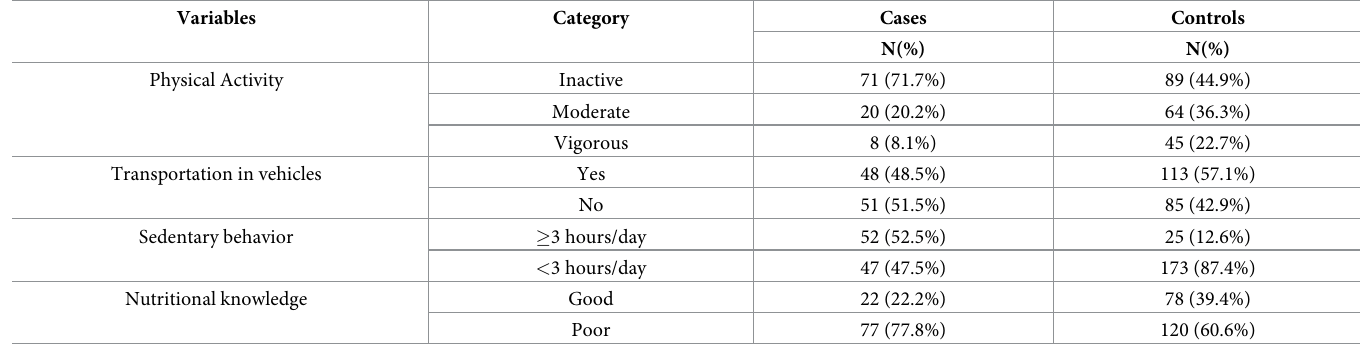
Table 3. Distribution of physical, sedentary behaviors, recreational activities, and nutritional knowledge related factors of overweight and/or obesity among school adolescents in Butajira Town, Southern Ethiopia, 2019. Variables